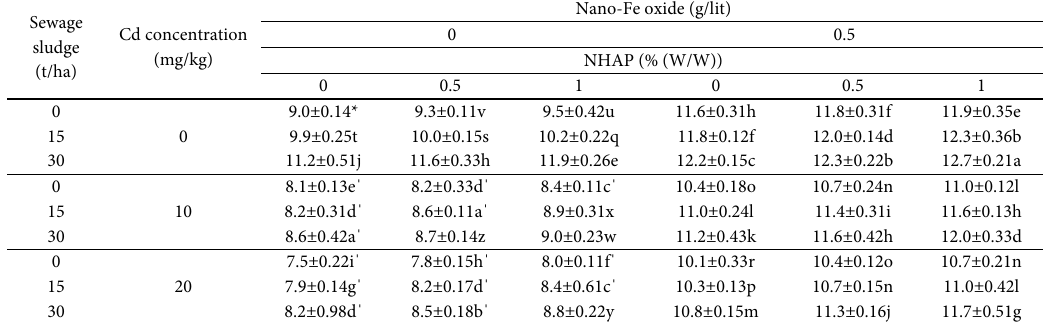
Table 5. Effect of foliar application of Nano-Fe oxide, NHAP, and Cd- polluted sewage sludge on plant Zn concentration